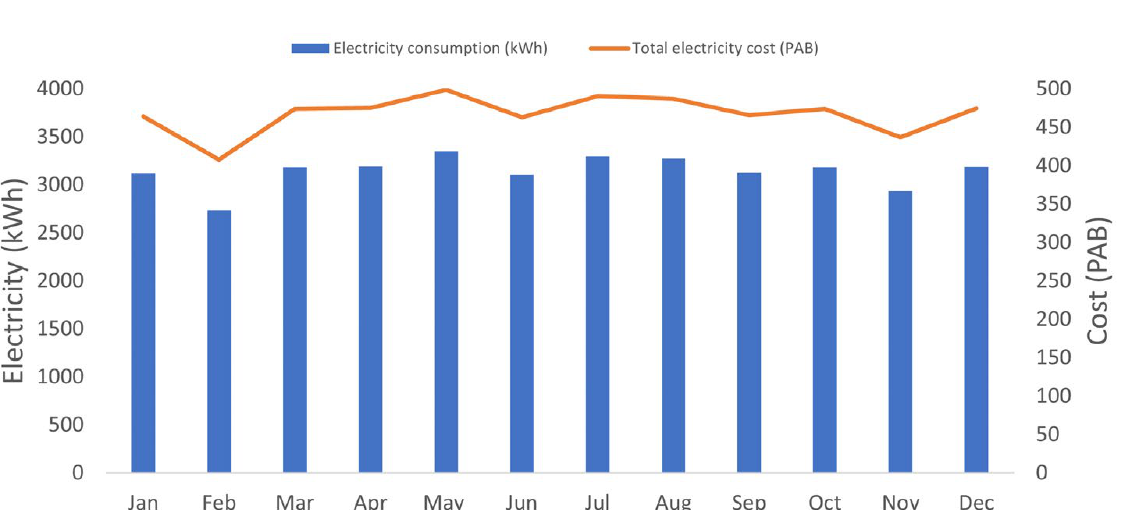
Table 9. Optimization analysis results obtained with the design variables selected. Electricity Consumption (kWh)